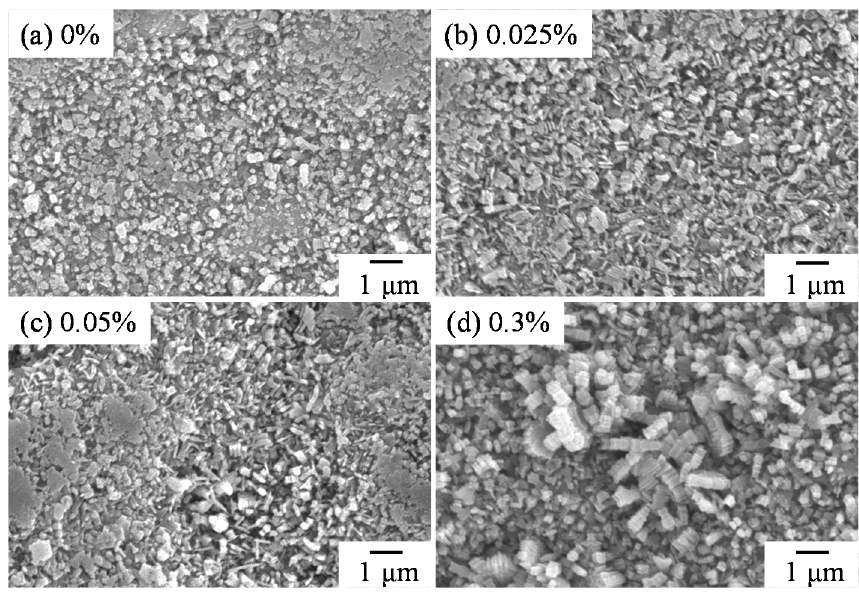
Figure 5. SEM images of surfaces of M10- x Cr-973 K/10 h samples. ( a ) 0%; ( b ) 0.025%; ( c ) 0.05%; ( d ) 0.3%.